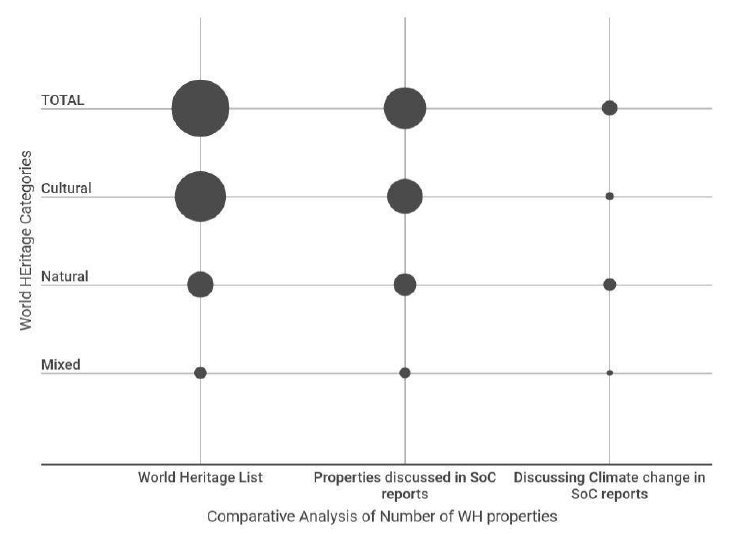
Figure 2. Comparison between total World Heritage (WH) properties and properties in State of Conservation reports discussing climate change.